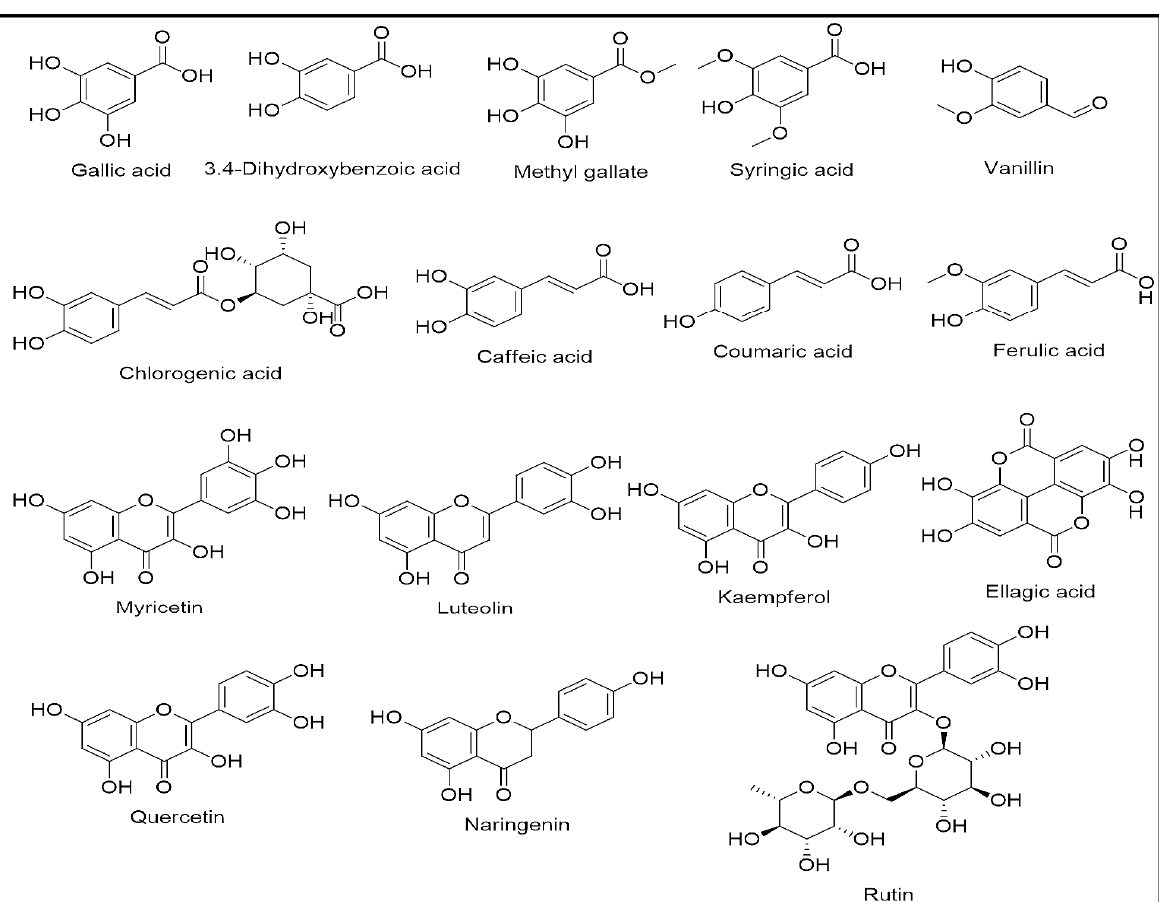
Figure 1. Structures of phenolics and flavonoid compounds identified from E. chamaesyce .